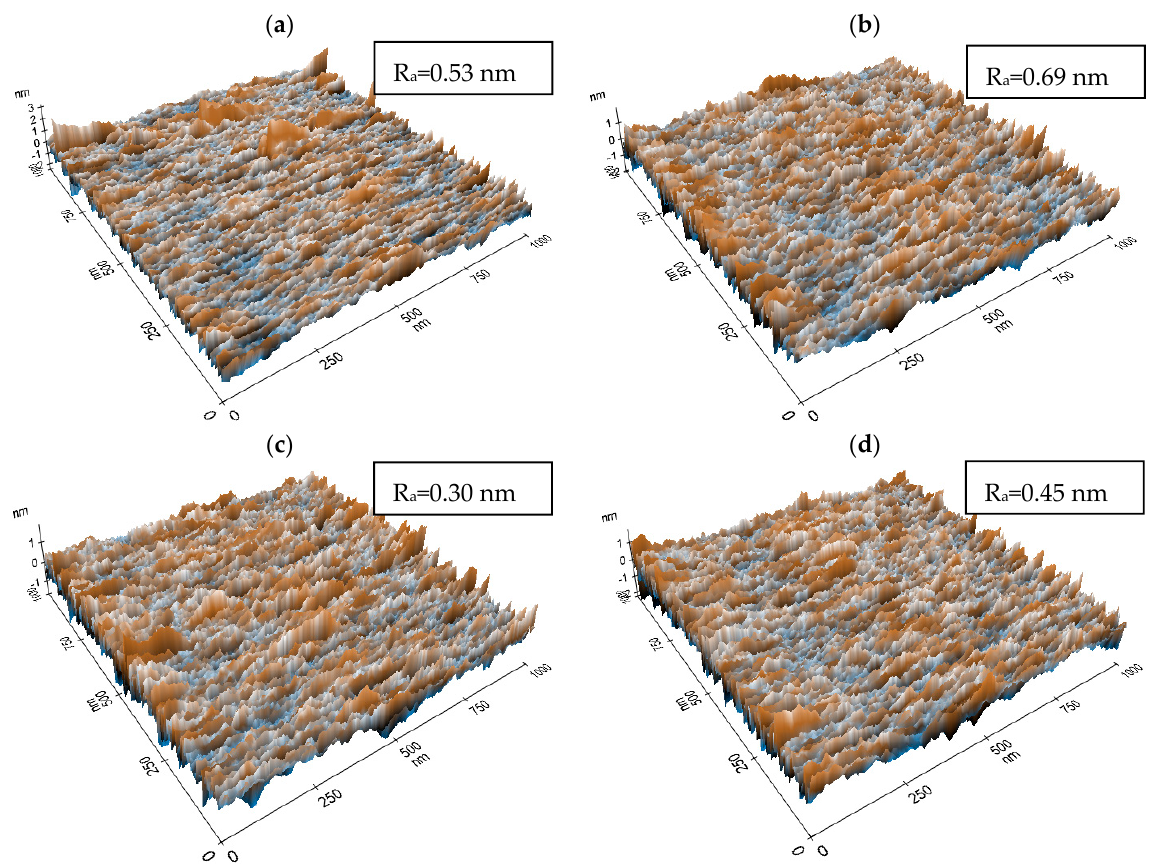
Figure 4. AFM topography and roughness of ( a ) S1, ( b ) S2, ( c ) S3, and ( d ) S4 where the average roughness is (R a ).